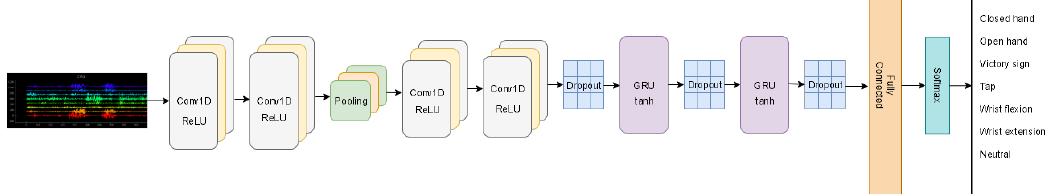
Figure 2. Proposed neural network architecture for hand gesture